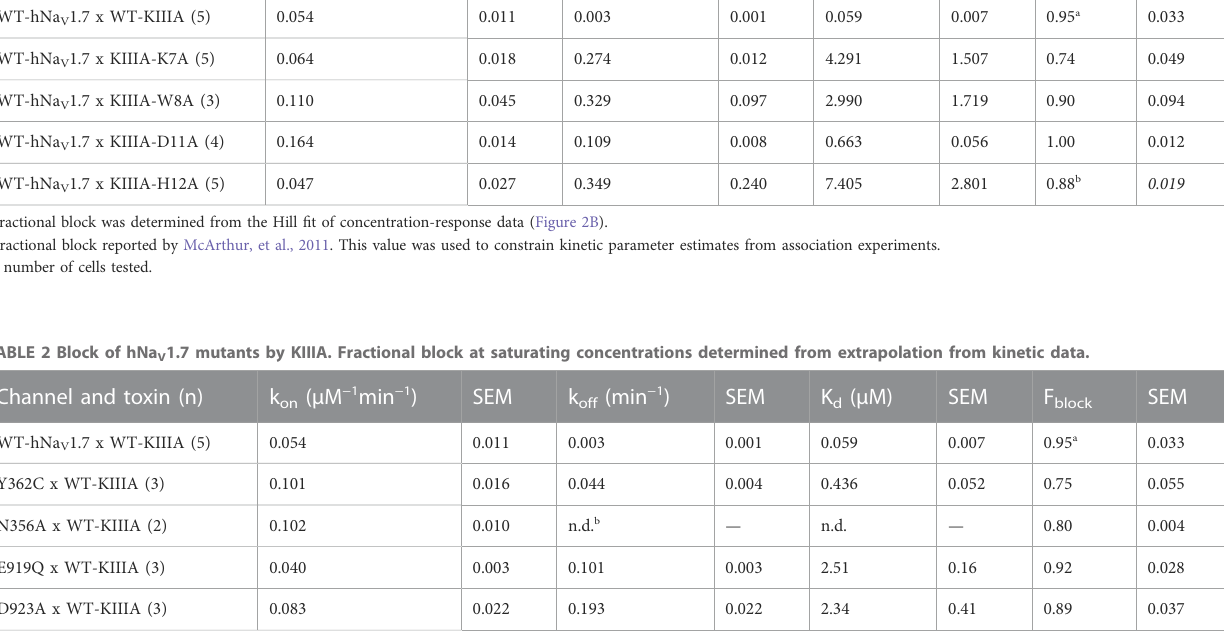
TABLE 1 Block of hNa V 1.7 by KIII variants Fractional block at saturating concentrations determined from extrapolation from kinetic data. Channel and toxin (n)